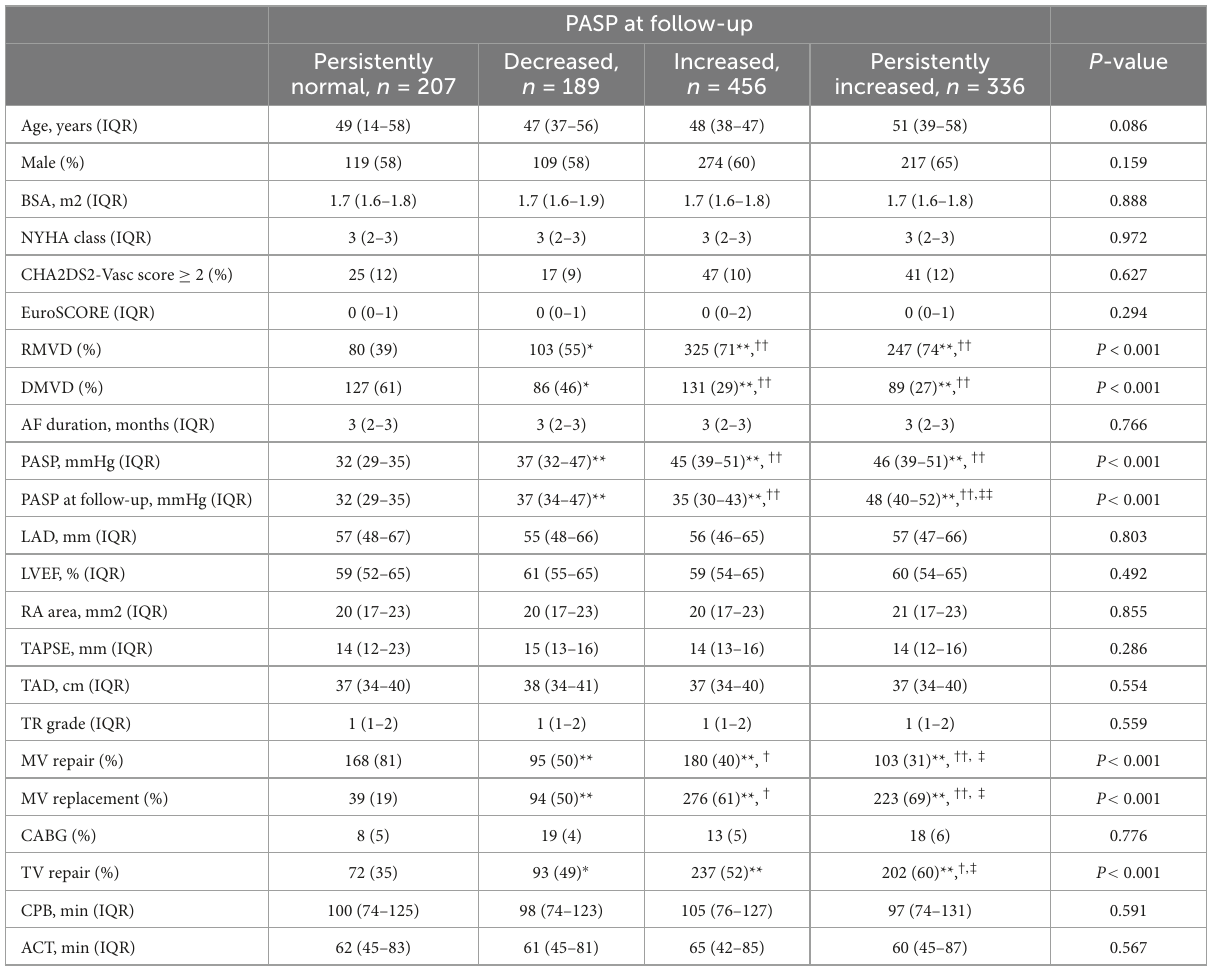
TABLE 2 Baseline characteristics of patients according to changes of PASP at